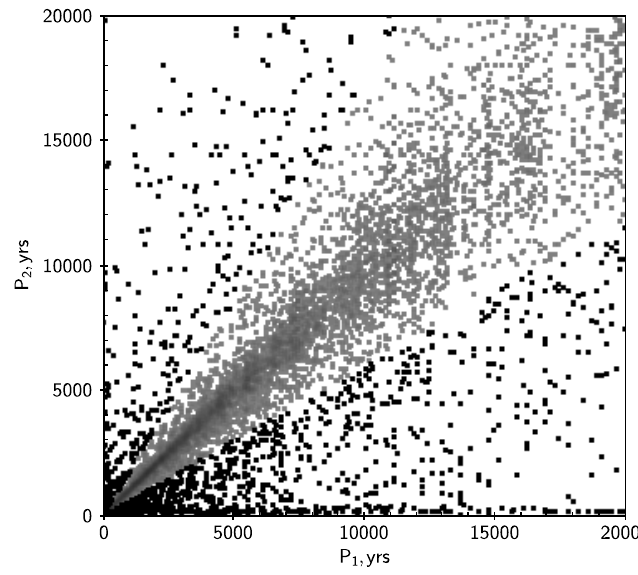
Fig. 1. Period estimates for the same wide binaries obtained by different couples of positions (based on data for 8000+ binaries with three and more positions). Grey dots are within the sector where P 2 = P 1 ± 50%; this sector contains 80% of all